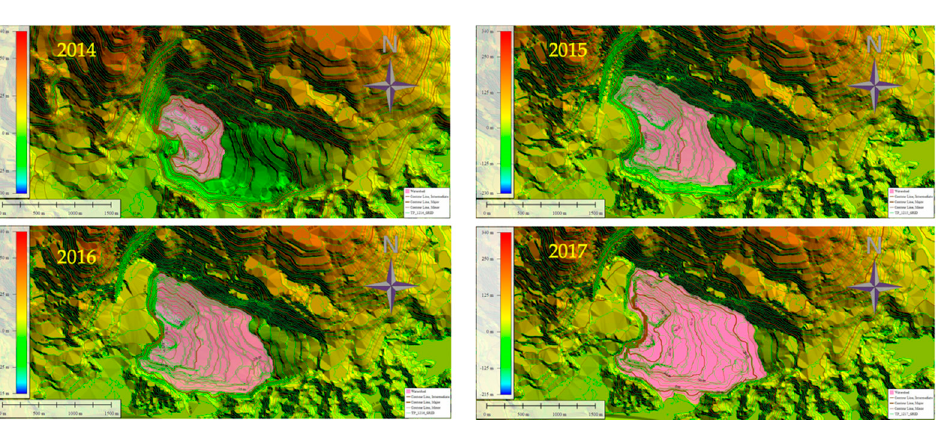
Figure 16. The development of a pit lake process.